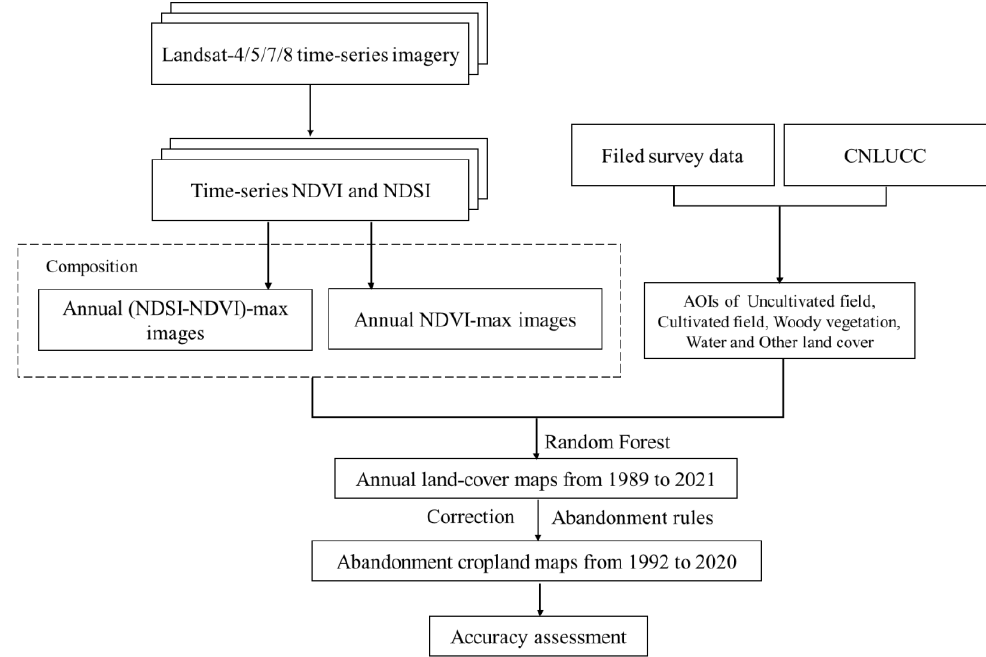
Figure 5. Workflow of monitoring cropland abandonment in Guangdong province from 1992 to 2020.